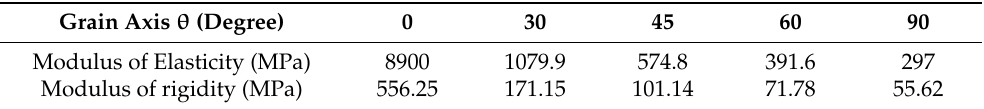
Table 3. Modulus of elasticity and modulus of rigidity of the poplar wood at various degrees in accordance with shear analogy approach using Hannkinson’s